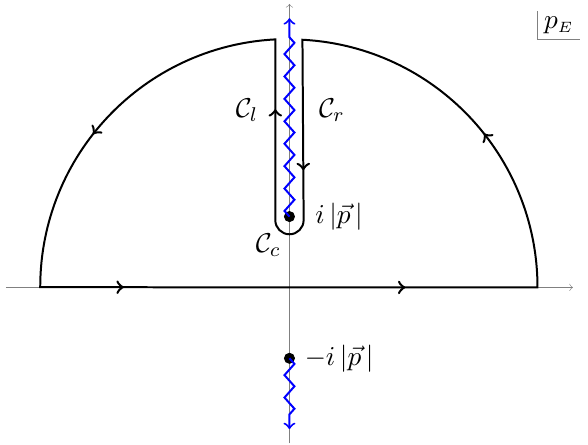
Figure 2 . Closed contour of integration. The contribution from the arc at infinity